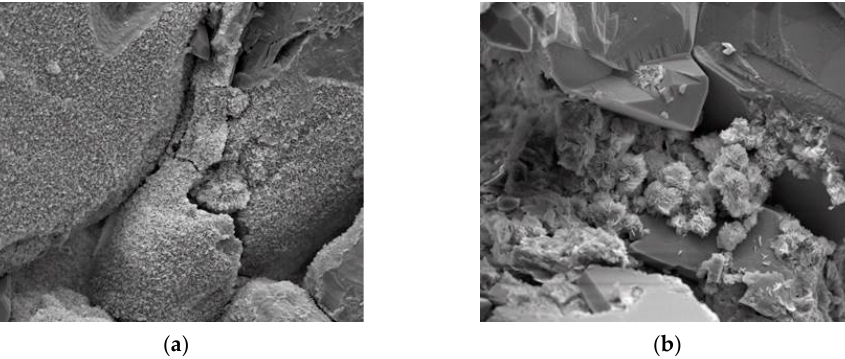
Figure 4. Occurrence of authigenic chlorite. ( a ) Pore lining chlorite, perpendicular to the particle surface, enveloping the particle, in H3 of well Y-2. ( b ) Pore filling chlorite, polymerizing and growing in the pores, no directionality in H3 of well X-2.